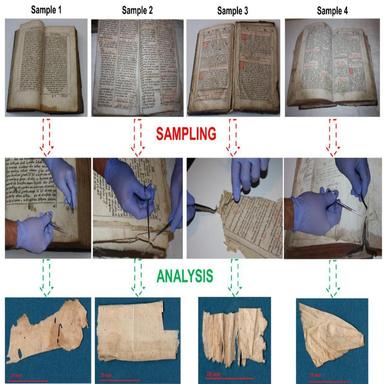
Images from the sampling procedure and the sampled materials used for the analytical investigations. The analyses were performed on parts without any visible biodegradation marks, as close as possible to the centre of the sample.